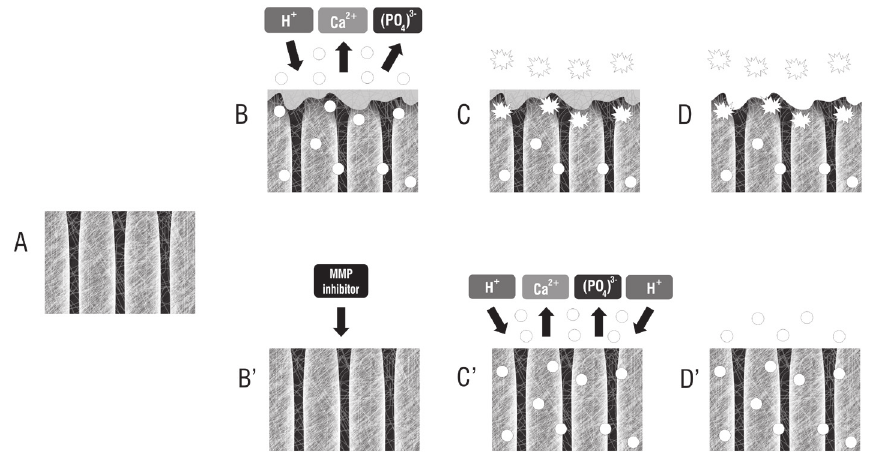
Figure 2- Proposed mechanism of action of Matrix Metallloproteinases (MMPs) on dentin erosion. Spheres: inactive MMP. Asterisk shapes: active MMP. (A) Sound dentin. After the erosive challenge, the dentin surface is demineralized (B), causing the exposure of the collagen fibrils (C). When unprotected by a MMP inhibitor, the collagen fibrils are exposed by the action of the acid of the soft drink and the collagen fibrils hydrolysed (C, D). By the inhibition of dentin-bound and/or salivary MMPs (B’), the preserved organic layer prevents further demineralization during the subsequent erosive challenges (C’), resulting in a significant decrease in erosive wear (D’). Illustration modified from Kato, et al. 52